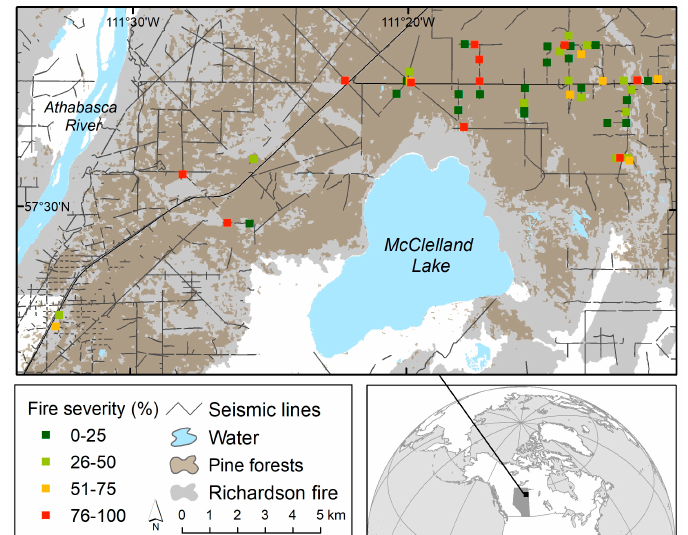
Figure 1. Location of study site in northeast Alberta, Canada (inset map), with the main map depicting the location of the 2011 Richardson fire (gray), unburned areas (white), pine forests (dark brown where burned and in a few places light brown where unburned), seismic lines, and sample sites symbolized by four levels of fire severity. Each site represents two-paired plots (a seismic line and an adjacent forest) with sites restricted to areas with no forest harvesting (not shown, but extensive in the area). Note that nearly all pine forests were burned and that some sites were within ~200 m of each other (not shown in this map) when stand and fire severity levels differed or there were gaps in the seismic line